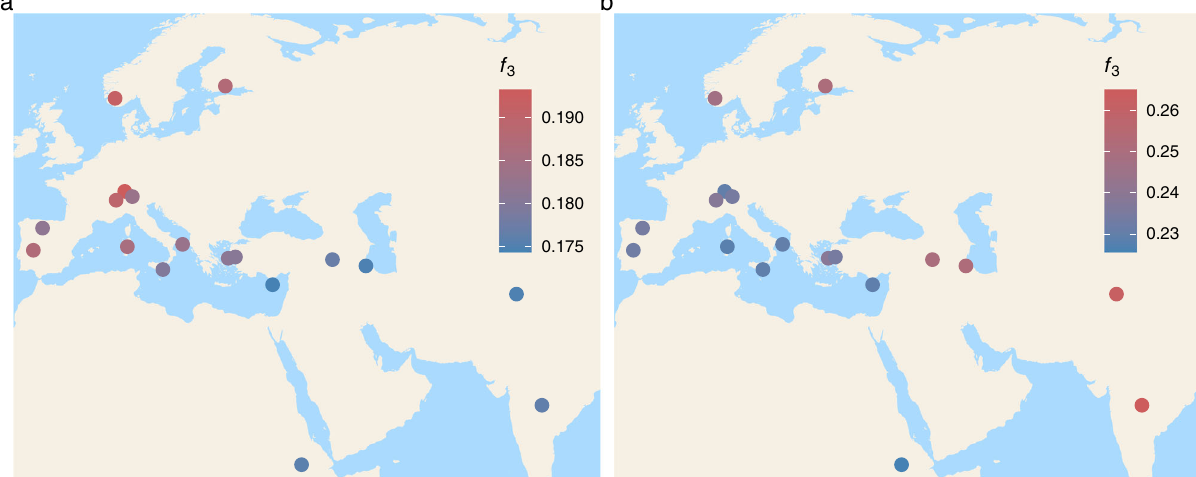
Fig. 3 Genetic similarity between ANS, OBI, and present-day sheep populations. Outgroup f 3 -statistics were used to measure similarity between ( a ) ANS and present-day breeds, calculated as f 3 (Argali; ANS, Modern) , using the joint allele frequencies of the four ANS individuals, ( b ) OBI and present-day breeds, calculated as f 3 (Argali; OBI, Modern) , using the joint allele frequencies of the three OBI individuals. The dots indicate the locations of present-day breeds (Supplementary Table 1). Redder tones re fl ect higher f 3 values, which indicate higher shared drift (i.e., higher similarity) between ancient and modern-day sheep. See also Supplementary Fig. 13 for outgroup f 3 -statistics calculated per ANS